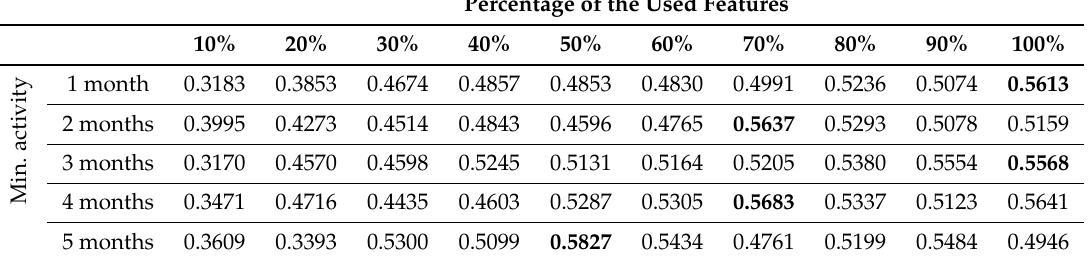
Table A16. F-score macro average for the Decision Tree classification of three levels of the hierarchy in the Enron dataset. The values which are bolded are the best results for a given minimum communication activity.